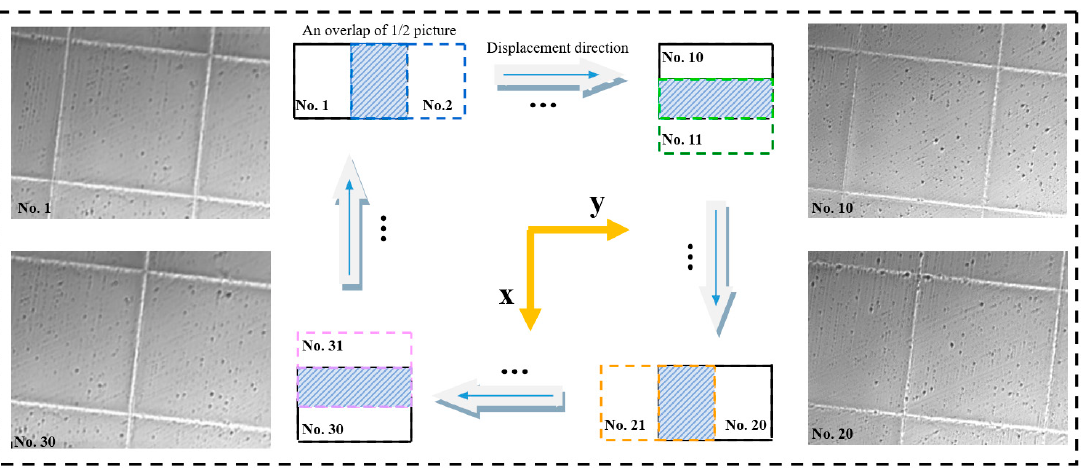
Figure 10. Image acquisition method. A total of 40 pictures were collected over multiple displace- ments by using the X-Y stage with a step size of half the width of the image (when it is displaced along the X-direction) or half the height (when it is displaced along the Y-direction). No.1 represents the first picture. No.2 represents the second picture, and so on.